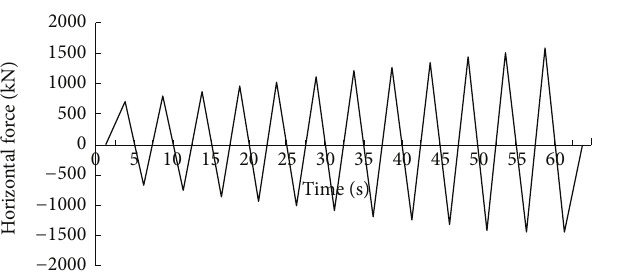
Figure 3: Low-period cyclic loading.